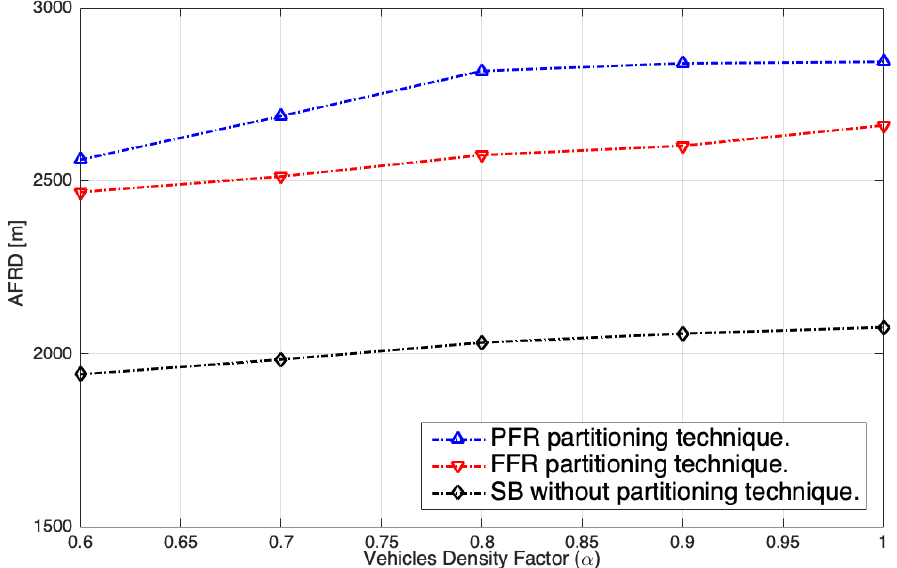
Figure 10. The average frequency reuse distance of CAM broadcasting messages by vehicles for different vehicle density factors for both bandwidth partitioning techniques: Full Frequency Reuse (FFR) and Partial Frequency Reuse